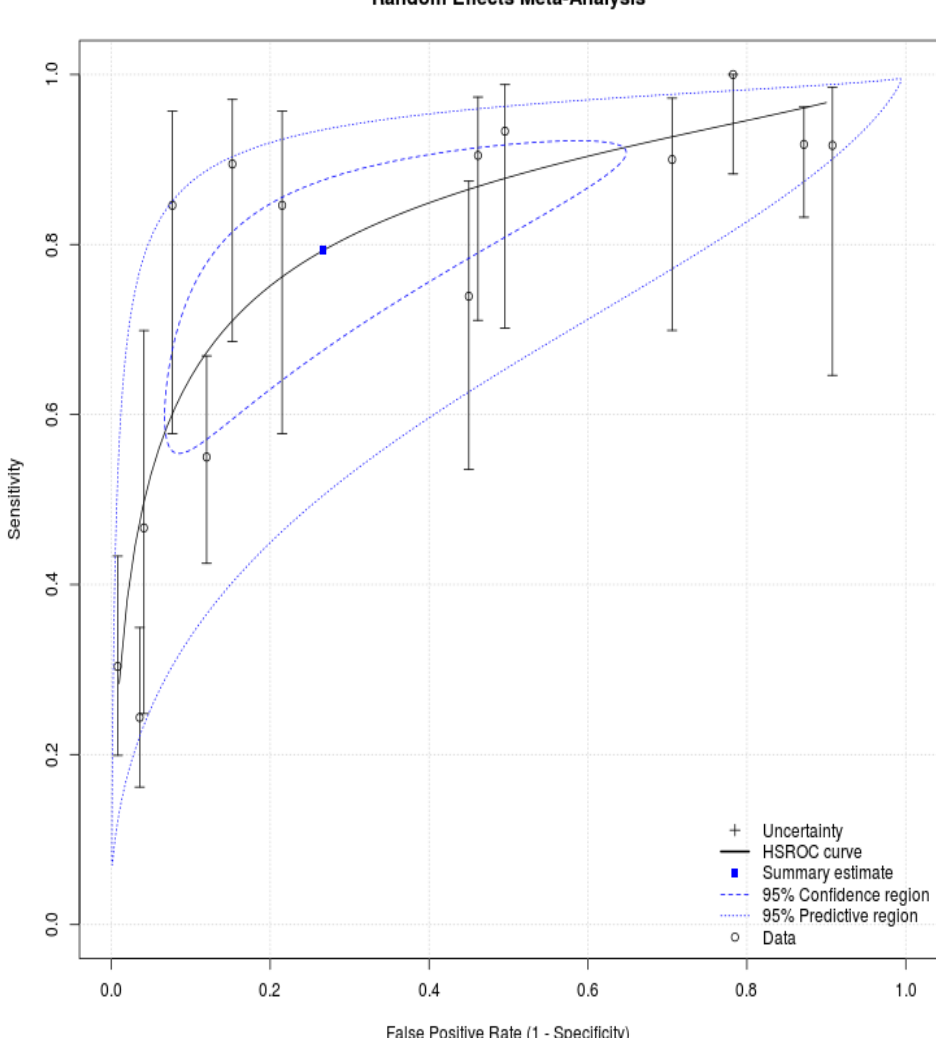
Figure 3. Summary receiver operating characteristic curves from all included studies. The dotted line represents the theoretical plot of a test with no discrimination. The black line represents the summary ROC curve that can be drawn through these values. The summary point estimate (blue spot) and its 95% confidence region around it (within the dotted lines). The height of the rectangles is proportional to the number of patients with traumatic bowel and mesenteric injuries across studies, the width of the rectangles corresponds to the number of patients without traumatic bowel and mesenteric injuries.